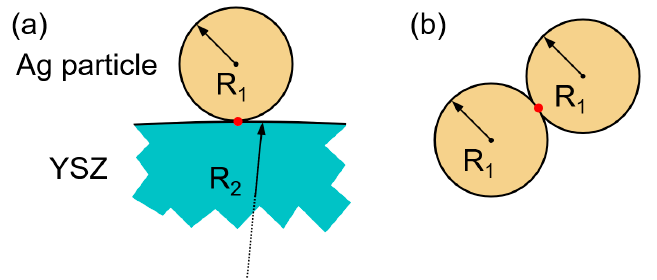
Figure 4. ( a ) Schematic diagram of Ag particle sintering with YSZ. ( b ) Schematic diagram of Ag particle sintering with adjacent Ag particle.